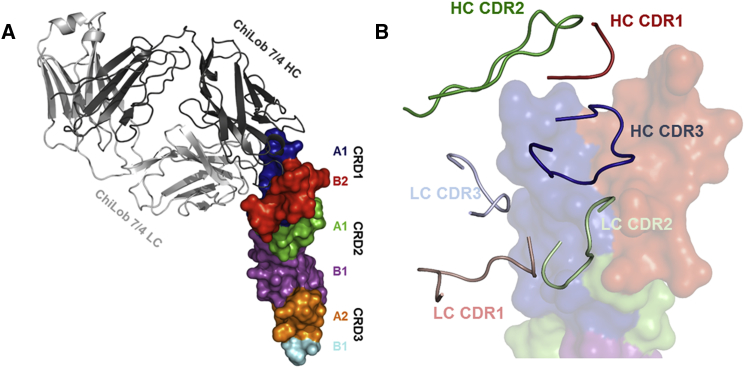
Crystal Structure of ChiLob 7/4 Fab' in Complex with CD40 Extracellular Domain(A) The crystal structure of the CD40:ChiLob 7/4 Fab' complex shows the Fab' in gray (dark gray, heavy chain; light gray, light chain) and CD40 colored by CRD (blue, CRD1-A1; red, CRD1-B2; green, CRD2-A1; magenta, CRD2-B2; orange, CRD3-A1; cyan, CRD3-B2 [partial]).(B) Interface, with structural elements removed for clarity. Shown are the CDR loops of ChiLob 7/4 in red for CDR1, green for CDR2, and blue for CDR3. Light color shades represent the light chain, dark shades the heavy chain. CD40 colored as in (A) (translucent). See also Table S1.